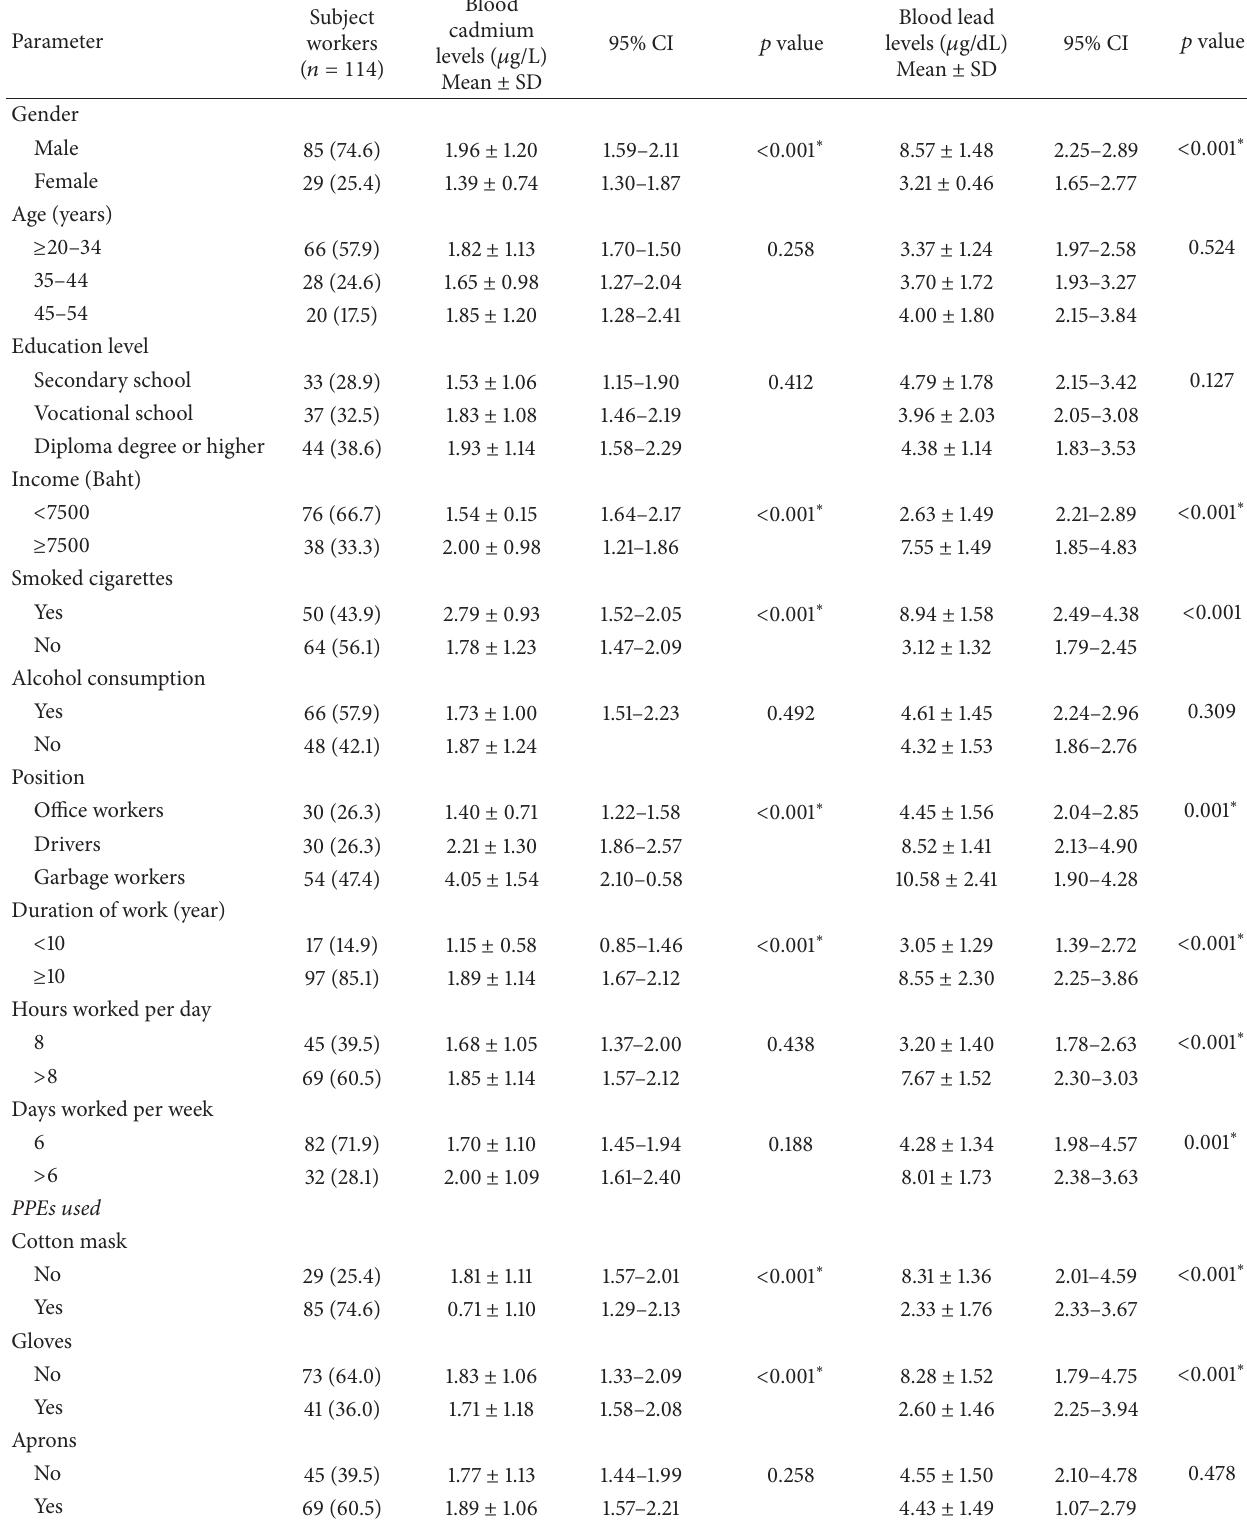
Table 5: Variables related to subject workers’ blood cadmium levels and blood lead